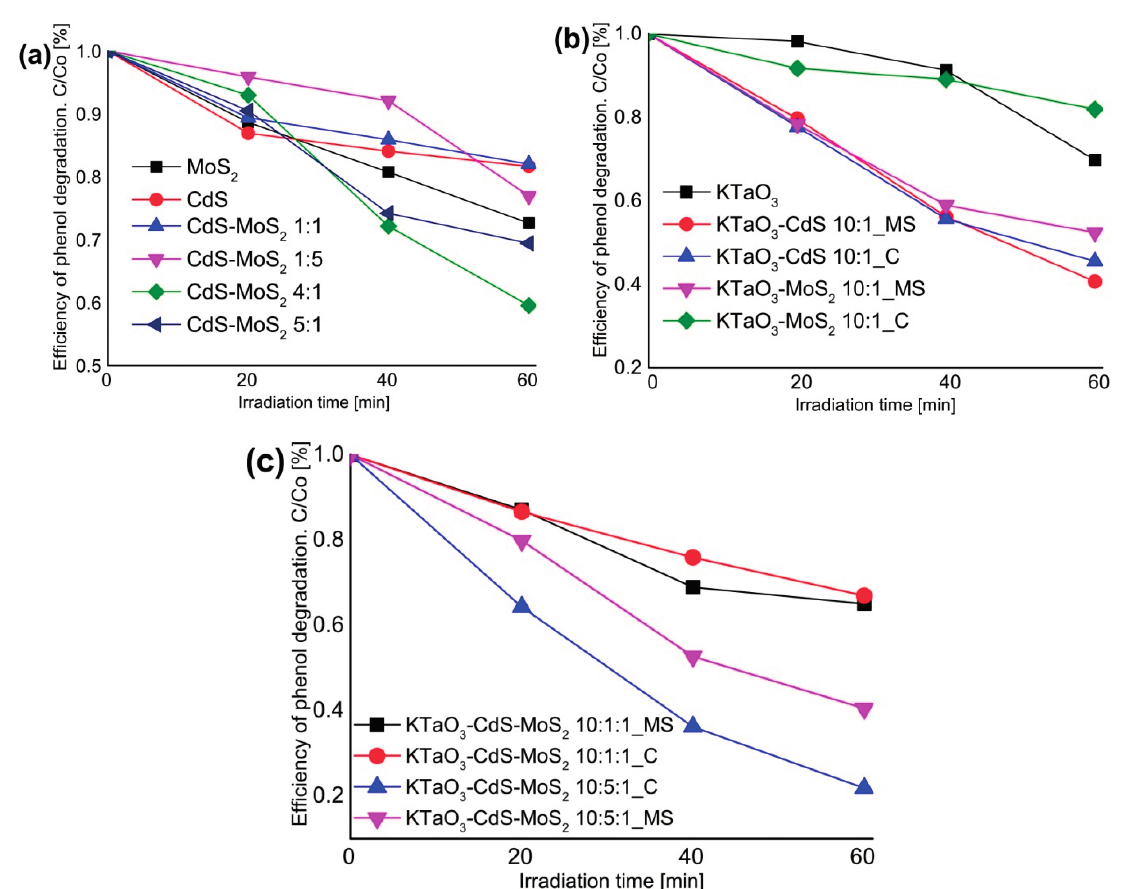
Figure 7. The percentage degradation of phenol at various time intervals under UV-Vis light in the presence: ( a ) single CdS, MoS 2 , and CdS-MoS 2 nanocomposites; ( b )